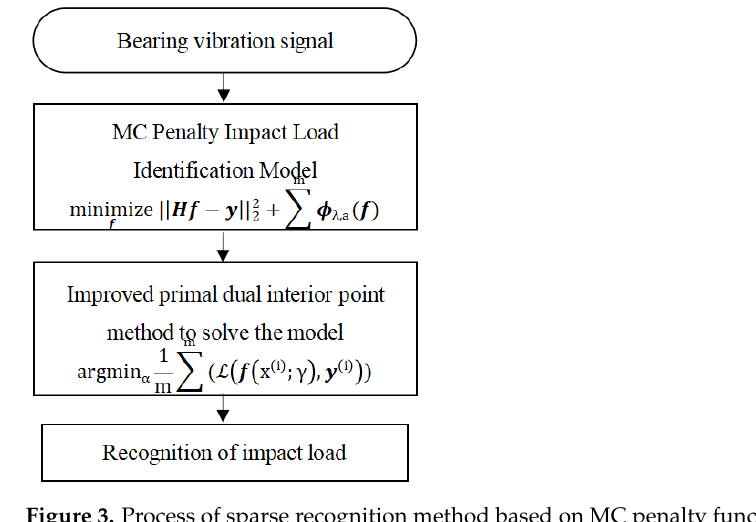
Figure 3. Process of sparse recognition method based on MC penalty function.